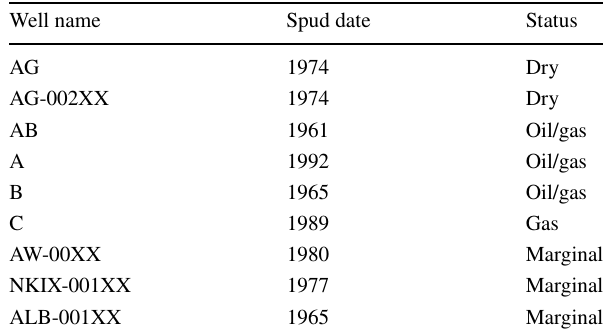
Table 1 Wells showing status of production in the selected area of